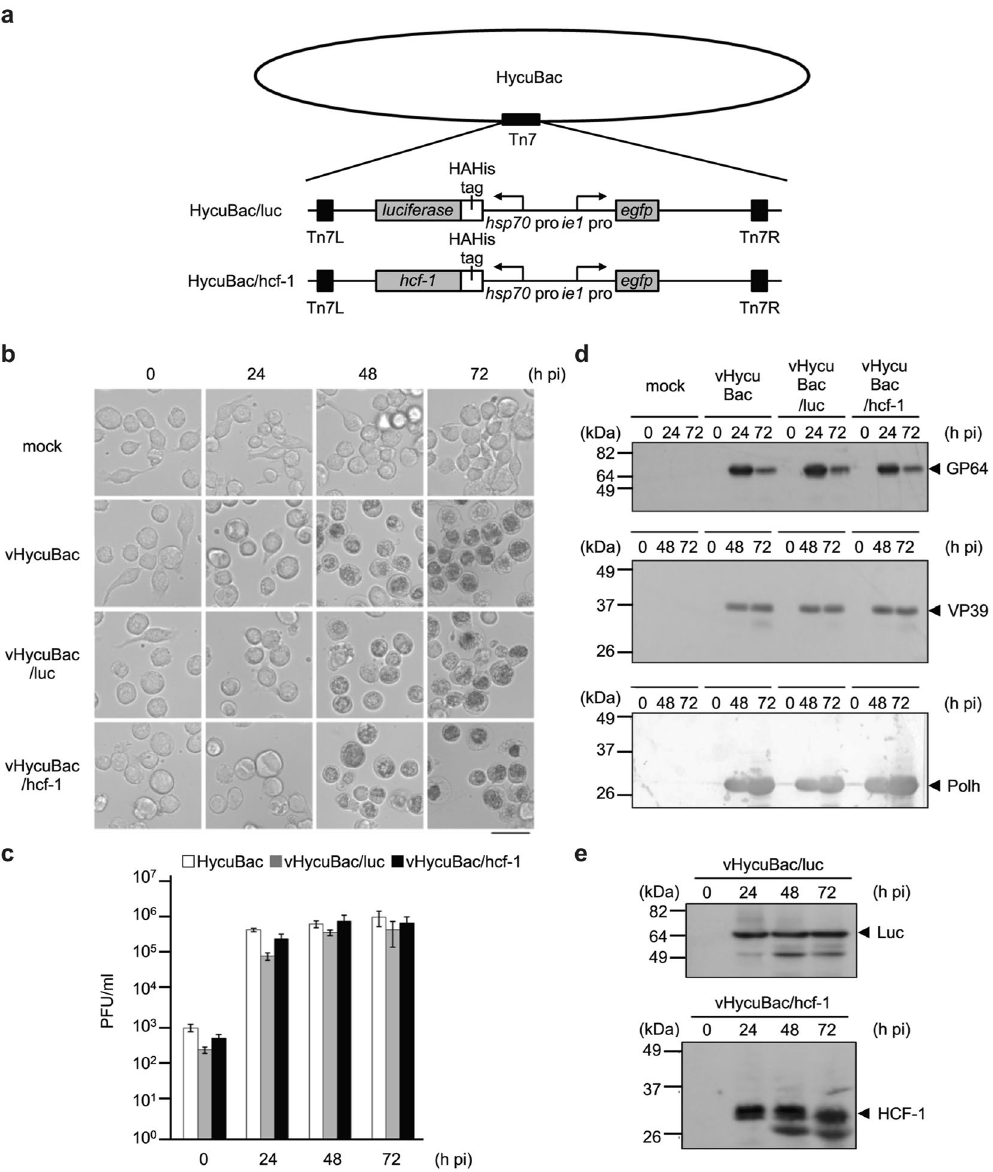
Figure 3. Characterization of recombinant HycuBac harboring hcf-1 (HycuBac/hcf-1) or luciferase gene (HycuBac/luc) in SpIm cells. SpIm cells were infected with vHycuBac or BVs derived from recombinant HycuBac/hcf-1 (vHycuBac/hcf-1) or HycuBac/luc (vHycuBac/luc) at an MOI of 5 and examined at 0, 24, 48 and 72 h post-infection (pi). ( a ) Schematic representation of HycuBac/luc and HycuBac/hcf-1. ( b ) Microscopic images of virus-infected SpIm cells. mock, Mock-infected SpIm cells. Scale bar, 50 μ m. ( c ) BV yields in virus- infected SpIm cells. BV titers were determined by a plaque assay using SpIm cells. The vertical bars represent the standard deviations of the averages from three determinations. ( d ) Immunoblot analysis of GP64, VP39 and polyhedrin (Polh) proteins in virus-infected SpIm cells. GP64 was probed with anti-GP64 monoclonal antibody and visualized using ECL Western Blotting Detection Reagent. mock, Mock-infected SpIm cells. For details on the detection and visualization of the VP39 and polyhedron proteins, see the legend of Fig. 1e. ( e ) Immunoblot analysis of luciferase and HCF-1 proteins in infected SpIm cells. For details on the detection and visualization of luciferase and HCF-1, see the legend of Fig. 1f. In panels ( d ) and ( e ), polypeptides equivalent to 1 × 10 5 cells were analyzed in each